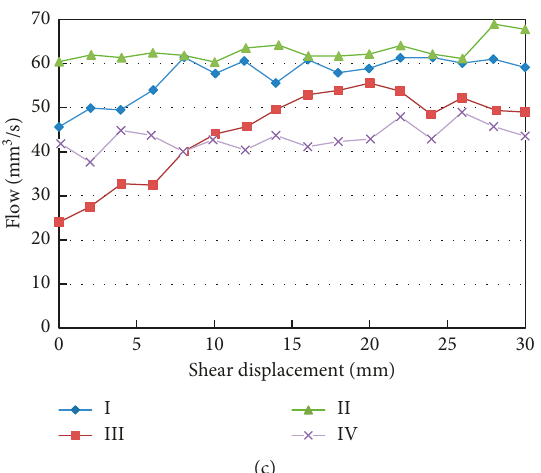
Figure 12: Variations in flow with increasing shear displacement. (a) Increasing normal stress. (b) Increasing shear velocity. (c) Changes in the fissure plane combination mode.